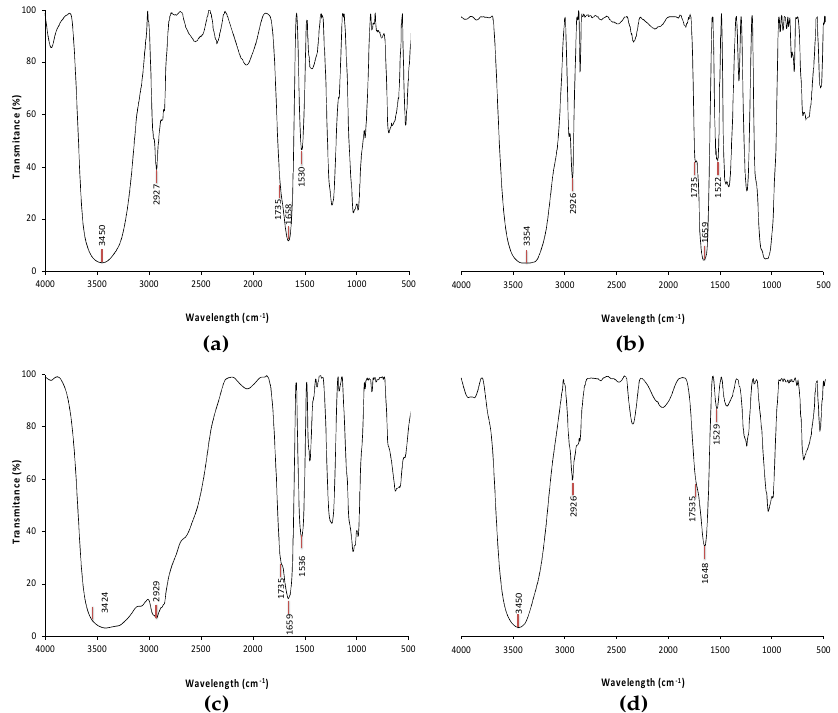
Figure 3. FT-IR patterns of pacaya protein isolates ( a ) extracted from pacaya without thermal treatment; ( b ) extracted from pacaya under hydrothermal processing; ( c ) extracted from pacaya via steaming at an elevated temperature; ( d ) extracted from pacaya under microwave treatment.